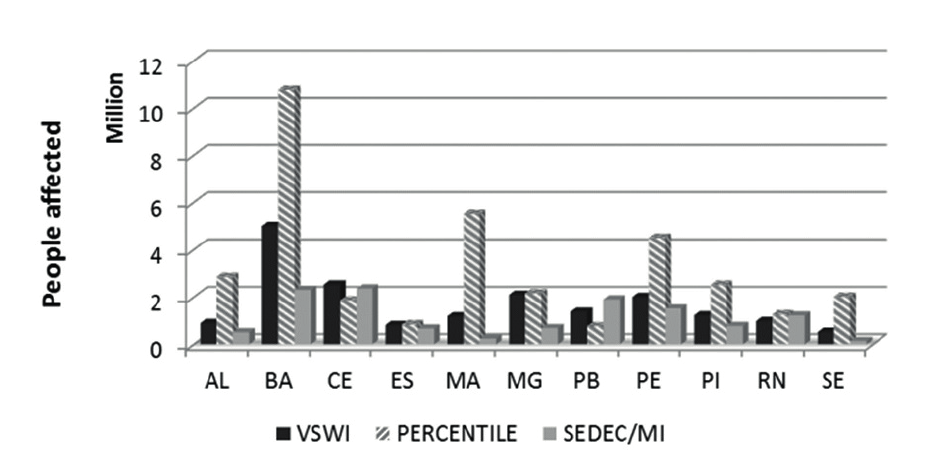
Figure 8 - People affected by droughts according to the methodology proposed (VSWI and precipitation percentile) and those duly recognized by the National Integration